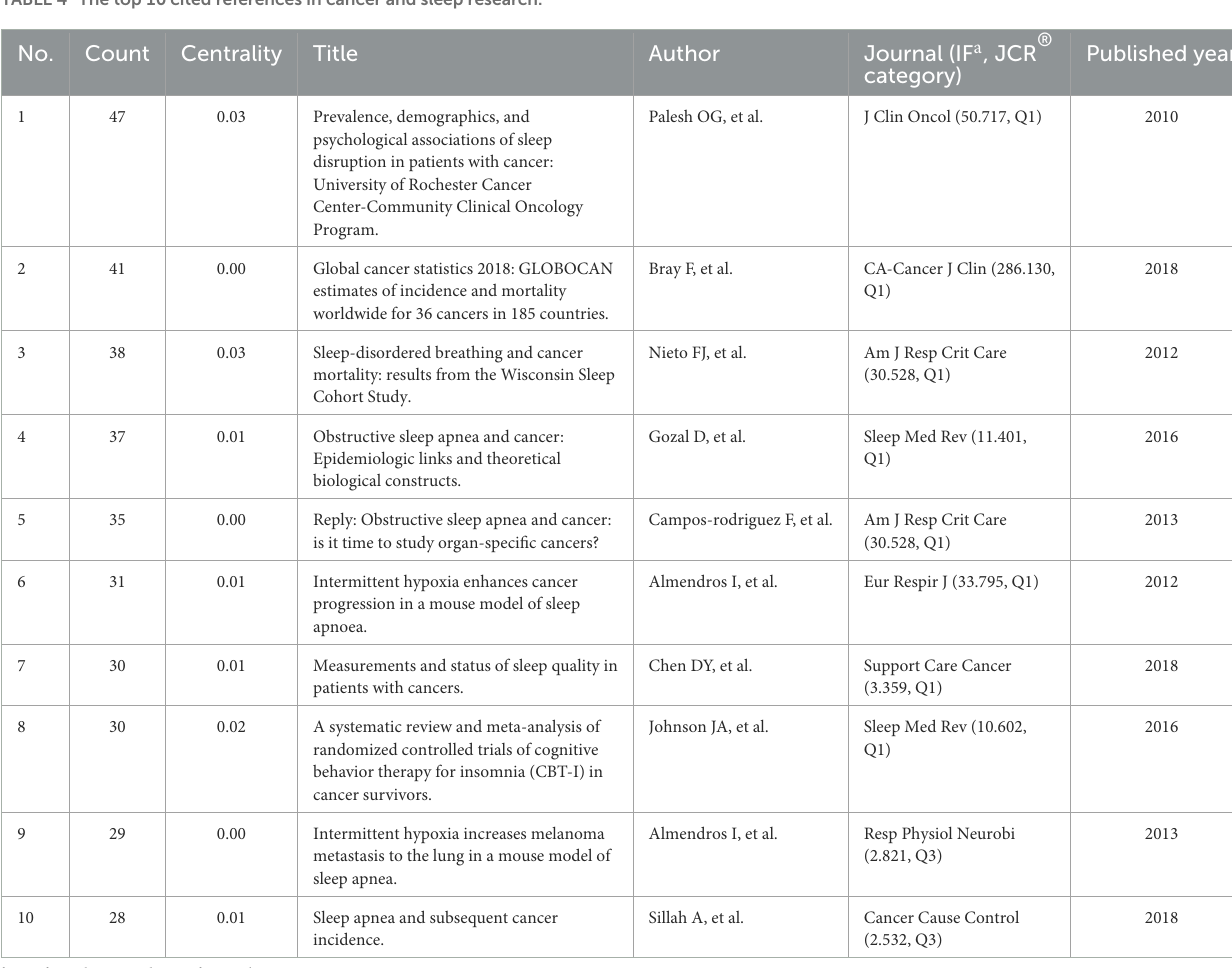
TABLE 4 The top 10 cited references in cancer and sleep